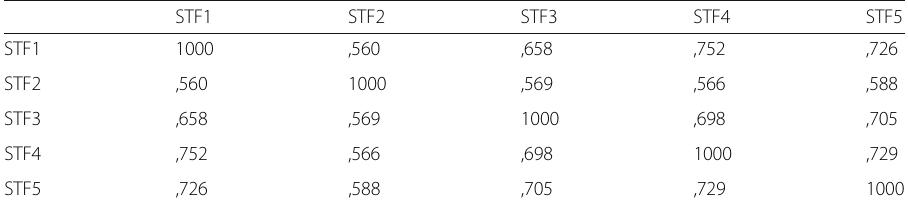
Table 12 Correlations on Satisfaction